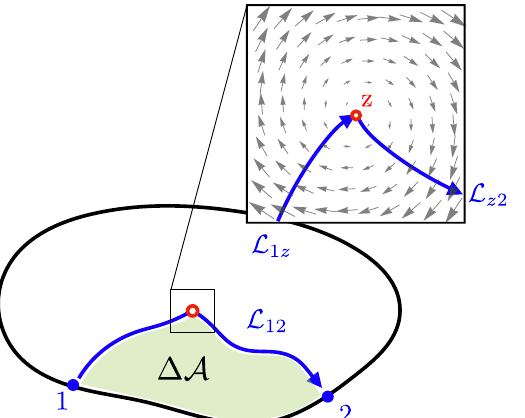
Fig. 2 Existence of zero phase paths on a generic surface of a superconducting lump with genus 0. Take two arbitrary points 1 and 2 on the surface of the superconductor. One can then always R (cid:3) A ¼ 0 . Such paths must fi nd a path L 12 with the property irr L 12 d l go through a zero point z in the vector fi eld on the surface, where A irr = 0. In the inset, a generic vector fi eld (gray) in the neighbor- hood of a zero z is drawn. The paths L 1 z and L z 2 are always perpendicular to A irr . When projected onto 2D, the zero phase path carves out an area Δ A of the superconductor. Fig. 3 Illustration of the argument why junction fi laments can be neglected. In ( a ), the circuit is drawn including the actual junction, whereas in ( b ) the junction is removed in the model. Instead, there is a path L filament (in red), which takes a path equivalent to the fi